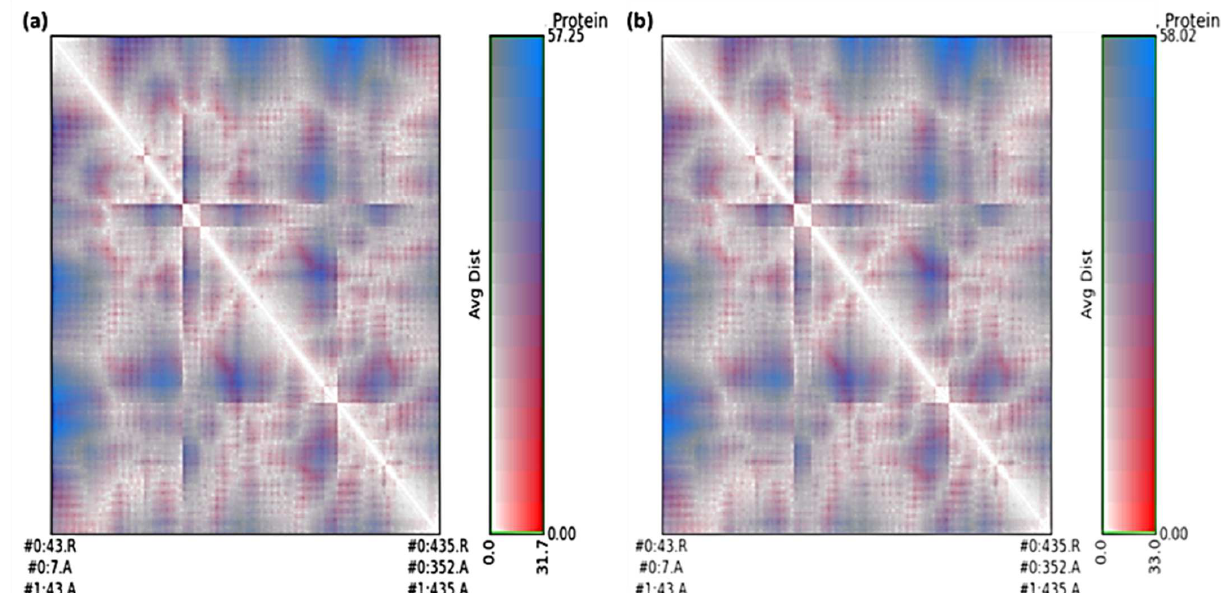
Figure 12. Superimposed structure after simulation of unbound dopamine receptor (red) and ( a ) CTcD (green), and ( b ) SRXD (blue). The average distance and standard deviation for all amino acid pairs between two conformations were calculated using RR distance maps [63]. In Figure 13, the patterns of spatial interactions are depicted using the RR distance maps [64].